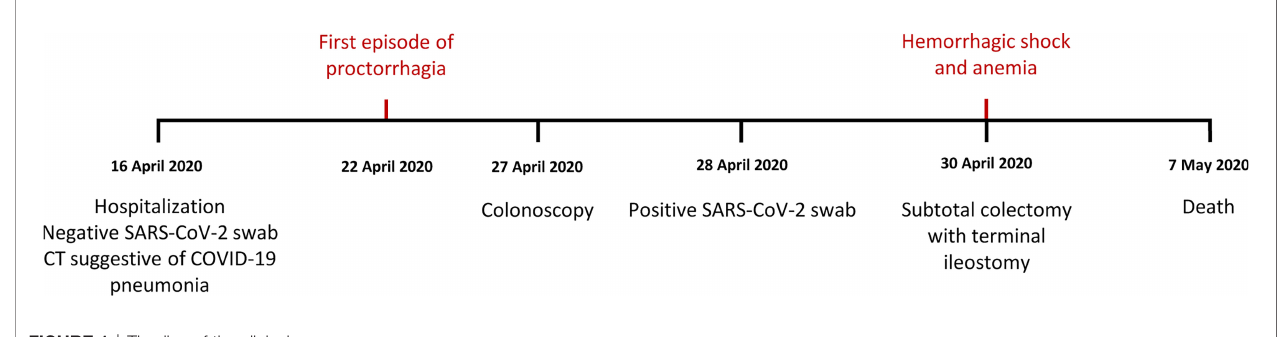
FIGURE 1 | Timeline of the clinical